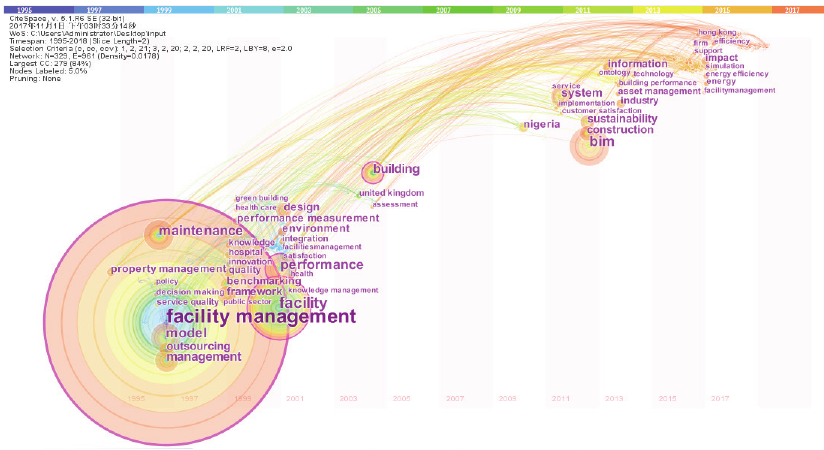
Figure 3. Time-zone view of the keyword co-occurrence